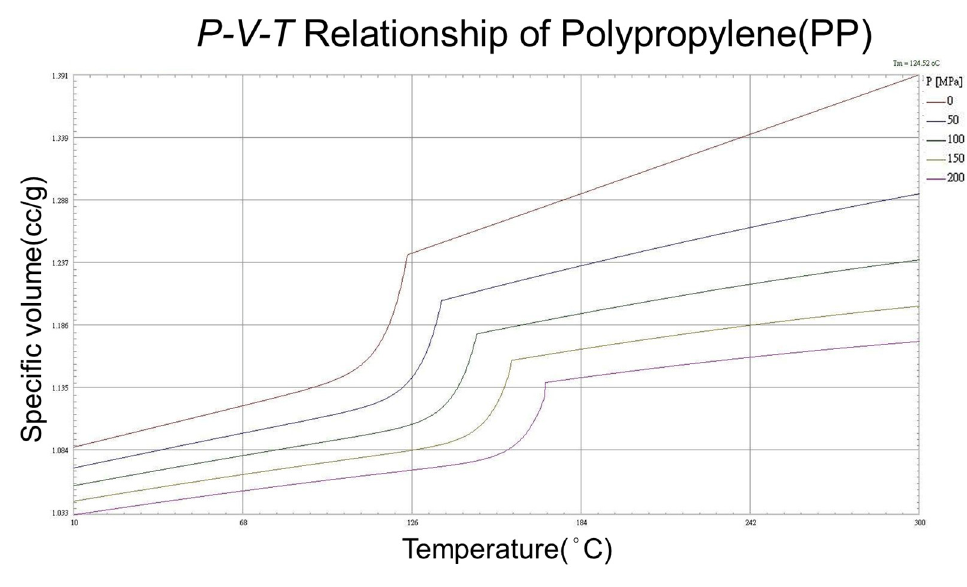
Figure 2. P-V-T Relationship of Polypropylene (PP).